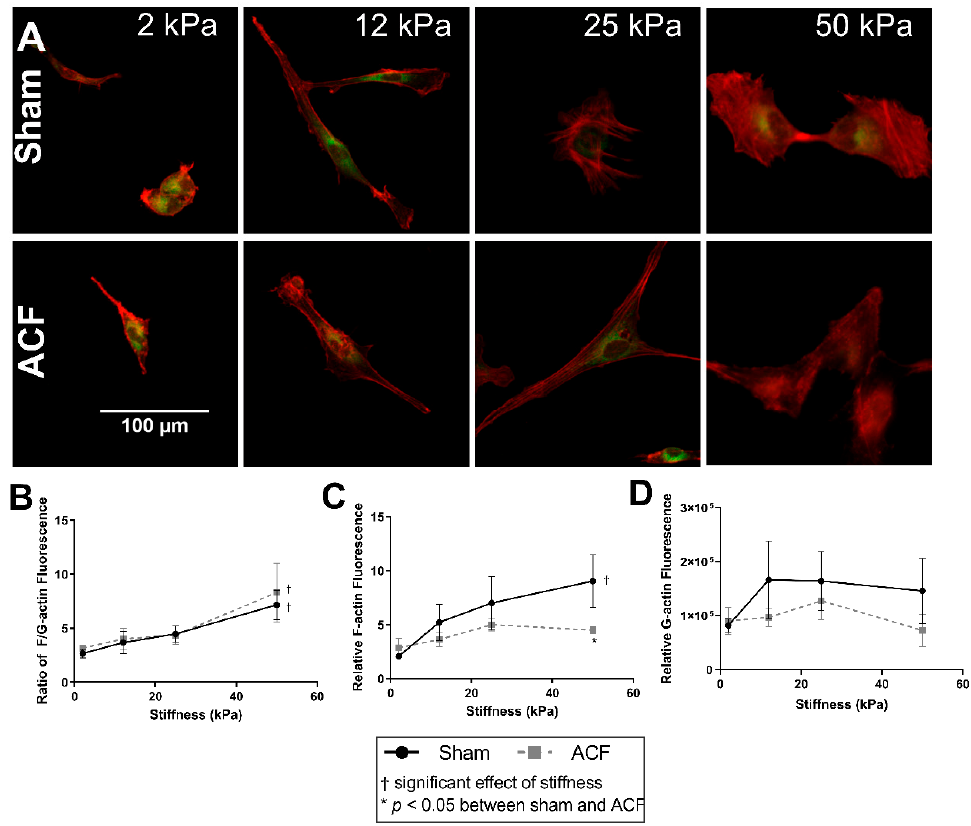
Figure 2. Increasing stiffness causes an increase in the F-actin-to-G-actin ratio in CFs from both sham and ACF as measured by fluorescent image analysis. ( A ) Sham (top row) and ACF (bottom row) CFs plated on polyacrylamide gels of a range of stiffness and stained with F-actin (red) and G-actin (green). ( B ) Quantification of the ratio of relative F-actin and G-actin fluorescence. ( C ) Relative F-actin fluorescence normalized to cells on a range of stiffness. ( D ) Relative G-actin fluorescence normalized to cells on a range of stiffness. * indicates p < 0.05 when comparing sham vs. ACF. † indicates a significant effect of substrate stiffness.